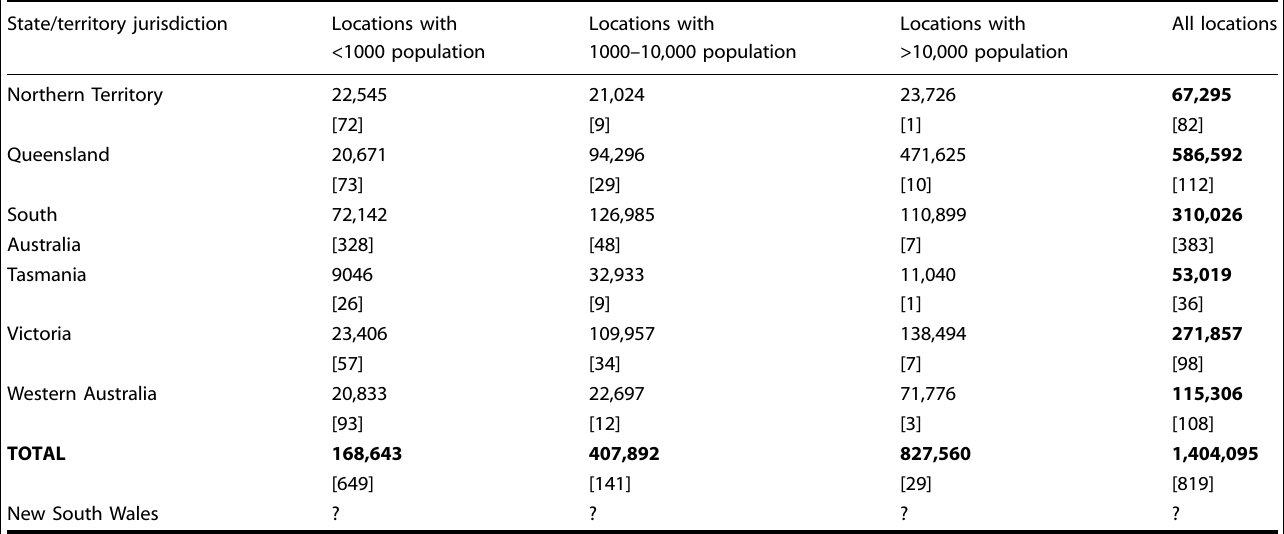
Table 5. Population and number of locations in regional and remote Australia reported to lack access to the ‘ Metropolitan ’ de fi nition of a basic level of drinking water quality.